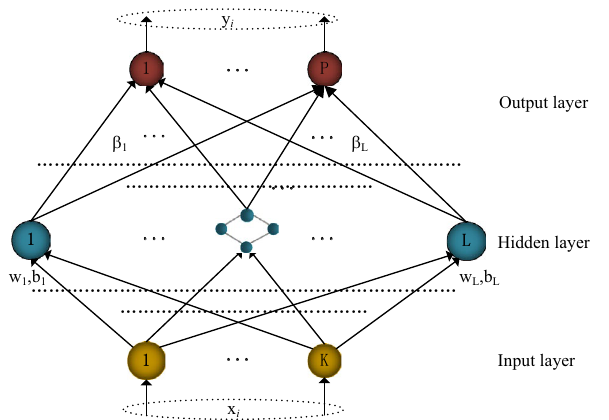
Figure 1. Topological diagram of